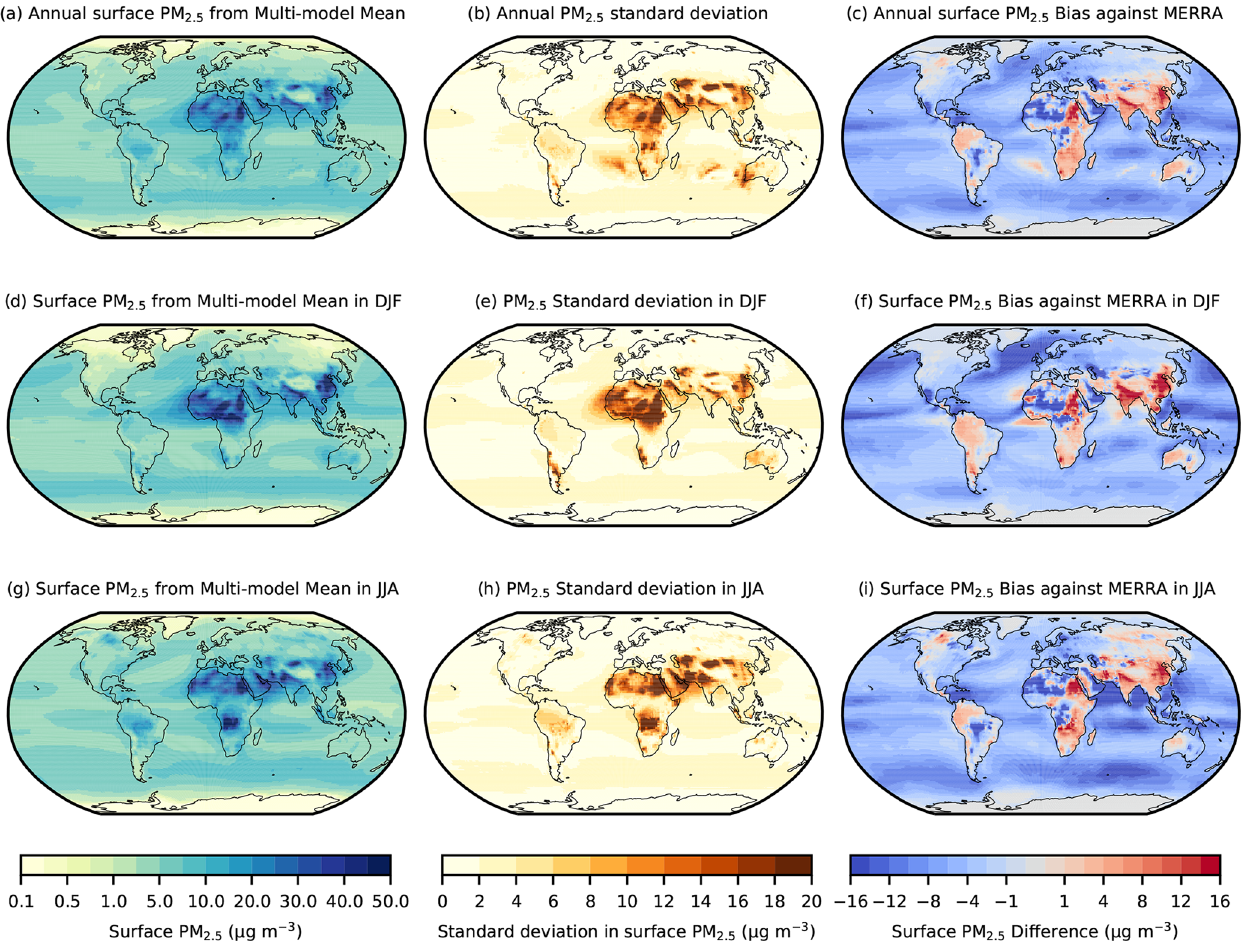
Figure 7. Multi-model (11 CMIP6 models) annual and seasonal mean surface PM 2 . 5 concentrations over the 2005–2014 period in (a) annual mean; (d) December, January and February (DJF); and (g) June, July and August (JJA). The SD of the multi-model mean in (b) annual mean, (e) DJF and (h) JJA. The difference between the multi-model mean and MERRA-2 reanalysis for (c) annual mean, (f) DJF and (i)